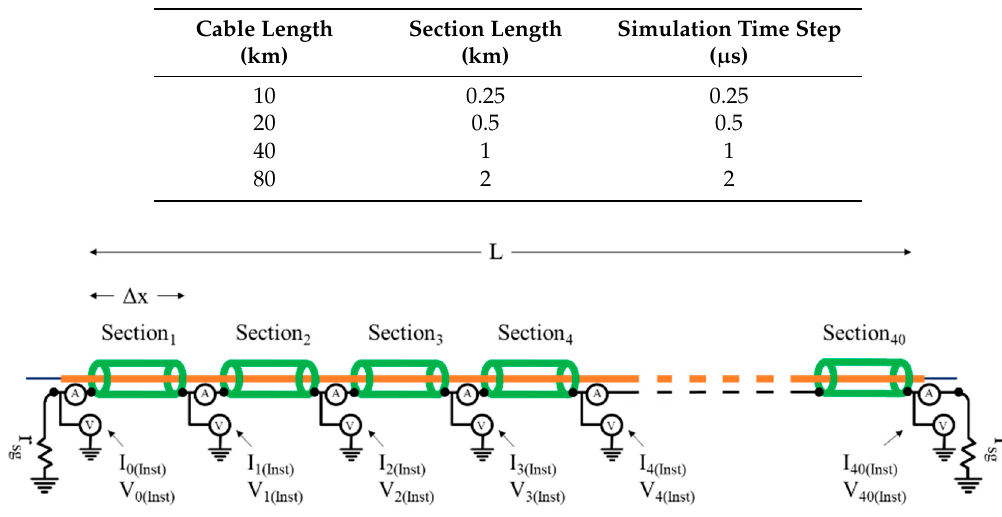
Figure 5. Evaluation of instantaneous sheath voltages and currents along the length of the cable.